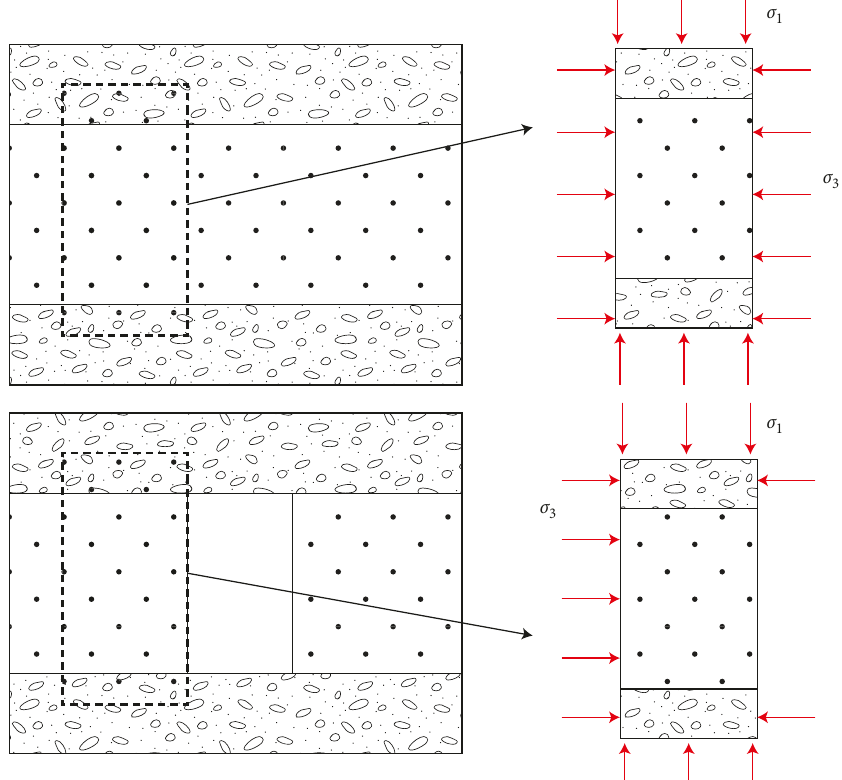
Figure 4: Schematic of the engineering geological model and engineering geomechanical model for strain burst considering different stiffness of the rock layers. The dashed rectangular frames in both graphs illustrate the zone including the excavation wall, roof, and floor that are discussed in this study.